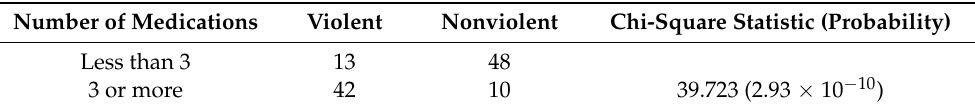
Table 4. Chi-square test of the use of antidepressants.